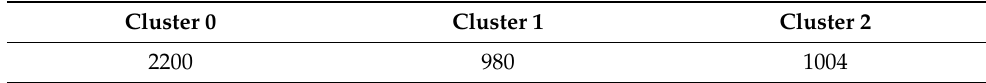
Table 4. Number of users for final